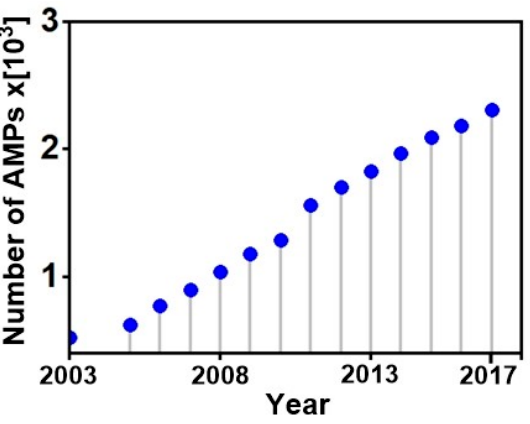
Figure 2. Number of AMPs isolated from natural sources since 2003 (information was extracted from the AMP database (http://aps.unmc.edu/AP).